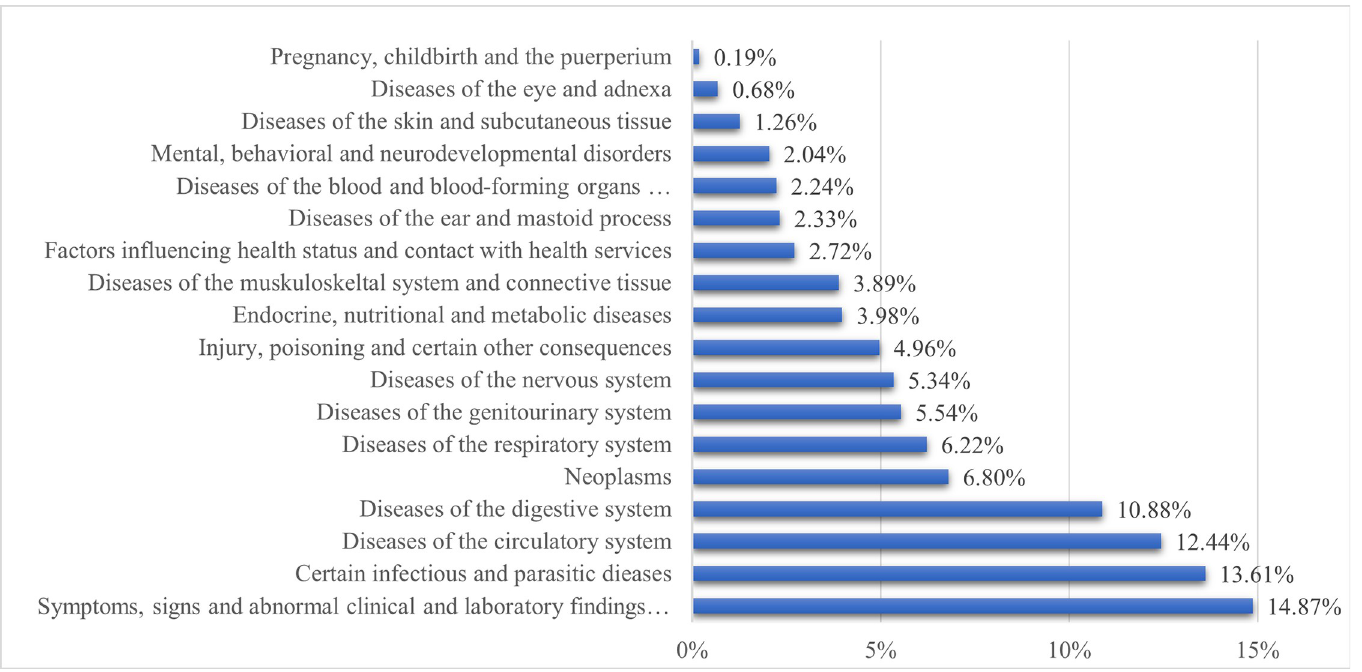
Fig 3. The relative frequencies of the ICD-10 chapters used in the presentational flow chart “unwell adult”.